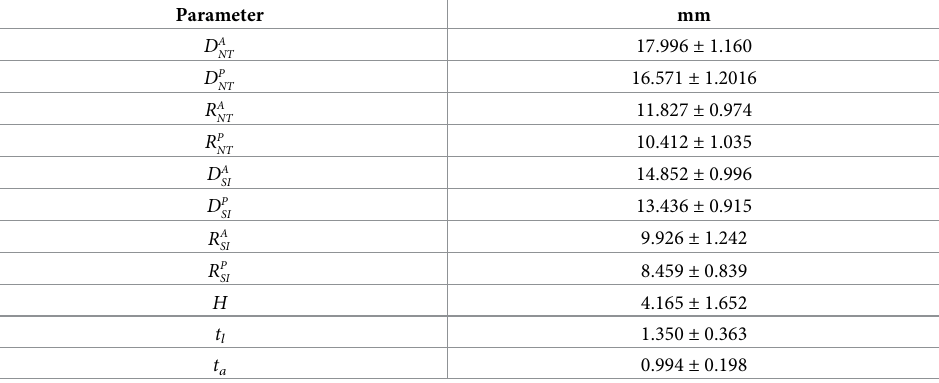
Table 1. Geometrical parameters of the pig